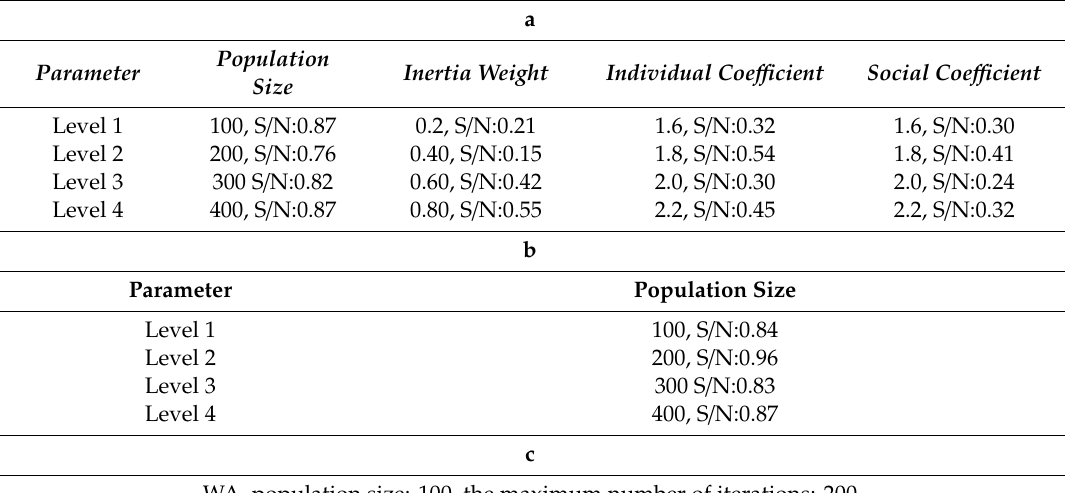
Table 2. ( a ) The parameter levels and signal-to-noise (S / N) ratio for the PSO, ( b ) the best parameters for the colliding bodies’ optimization (CBO), and ( c ) the best parameters for the whale algorithm (WA). a Parameter Inertia Weight Individual Coe ffi